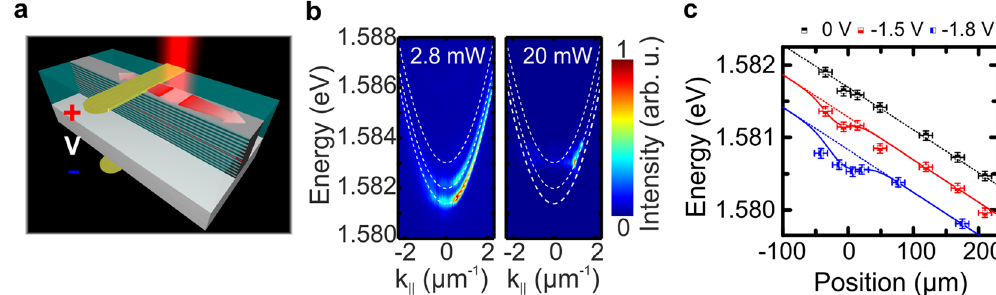
Figure 1. QW-microcavity polariton transistor switch sample and photoluminescence emission features. ( a ) Schematic image of the processed device consisting of the microwire and the electrical gate on top of the device. The excitation spot is located close to the contact, generating a propagating polariton flow. ( b ) Momentum resolved photoluminescence measurement at low power (2.8 mW, left) and far above the condensation threshold (20 mW, right) under open circuit conditions. Several lateral modes are visible and fitted by a coupled oscillator model (white dashed lines), yielding an exciton-photon detuning of δ = − 13.6 meV for the ground state with respect to the heavy hole exciton. Due to the gold contact, which blocks the PL underneath, the propagation for k || > 0 appears much brighter. ( c ) Spatially resolved PL measurements around zero in-plane wave vector, at low excitation power and several voltages. The reverse bias results in a general redshift of the intrinsic detuning gradient (dotted lines). Furthermore, a local energy minimum evolves underneath the 10 µ m wide contact centered at zero position with increasing reverse bias which can be described by an additional Gaussian shaped function (solid